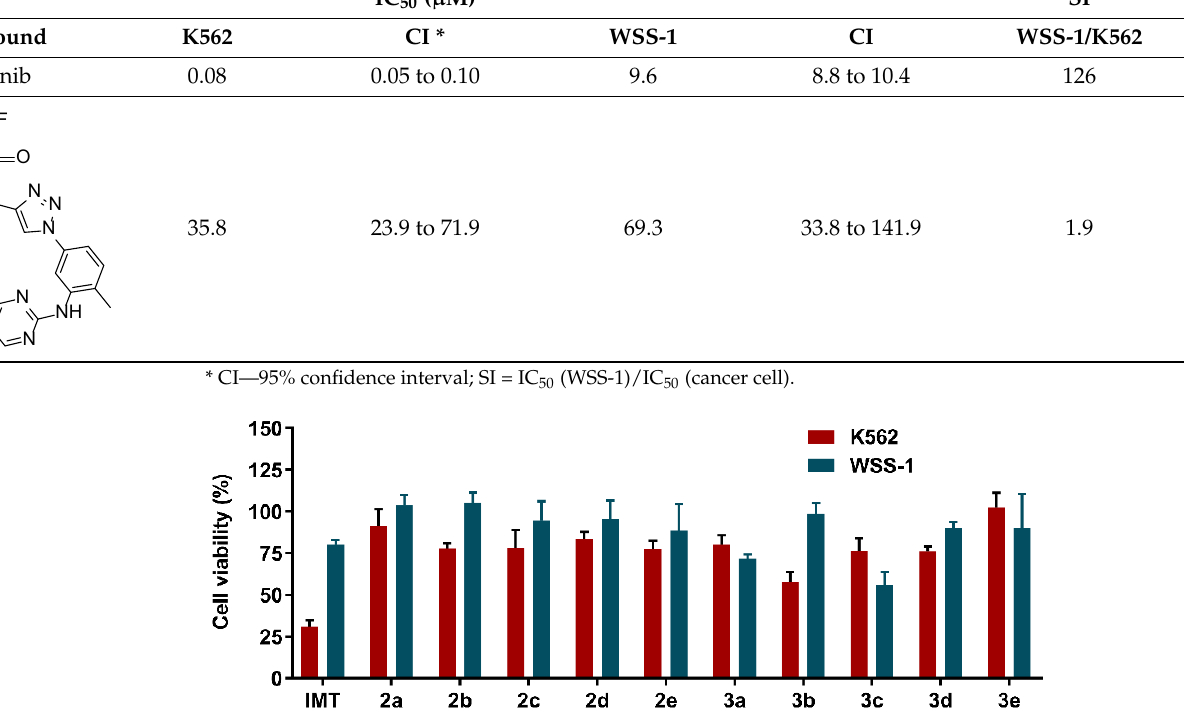
Figure 2. Screening of imatinib and its 2a–e and 3a–e derivatives at 10 µM concentration, against human cell lines K562 (in red) and WSS-1 (green). Bars represent the mean ± standard deviation. Table 1 shows the IC 50 and SI values of imatinib and its most cytotoxic analog, 3b, on K562 cells. Table 1. Cytotoxic activity and selectivity index of imatinib and derivative 3b in the K562 and WSS- 1 cells.